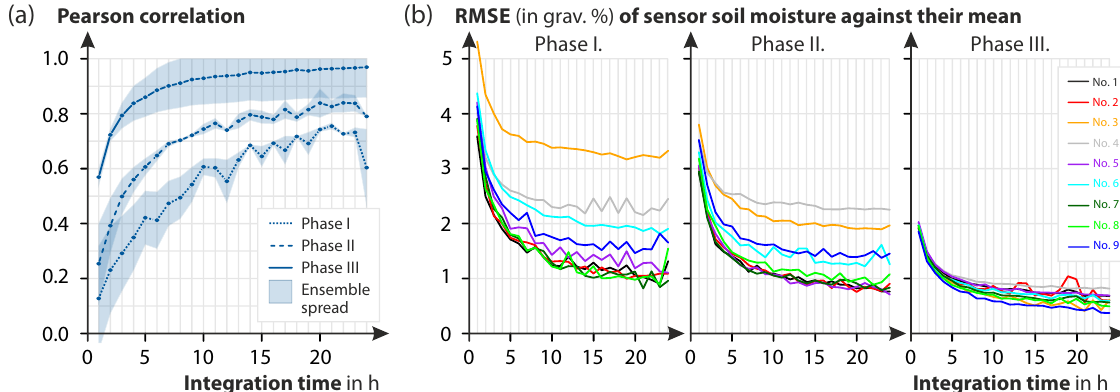
Figure 7. Influence of integration time, in hours (h), on the correlation and performance among the ensemble of nine sensors. (a) Ensemble- average Pearson correlation of the nine signals by twos for phases I, II, and III and temporal aggregation from 1 to 24h. (b) Root mean square error of the individual soil moisture products against the soil moisture product of the ensemble mean (cid:104) N (cid:105) . Accuracy below gravimetric water contents of 1% can be achieved for all sensors when sensor-specific offsets were removed (Phase III) and the integration time exceeds